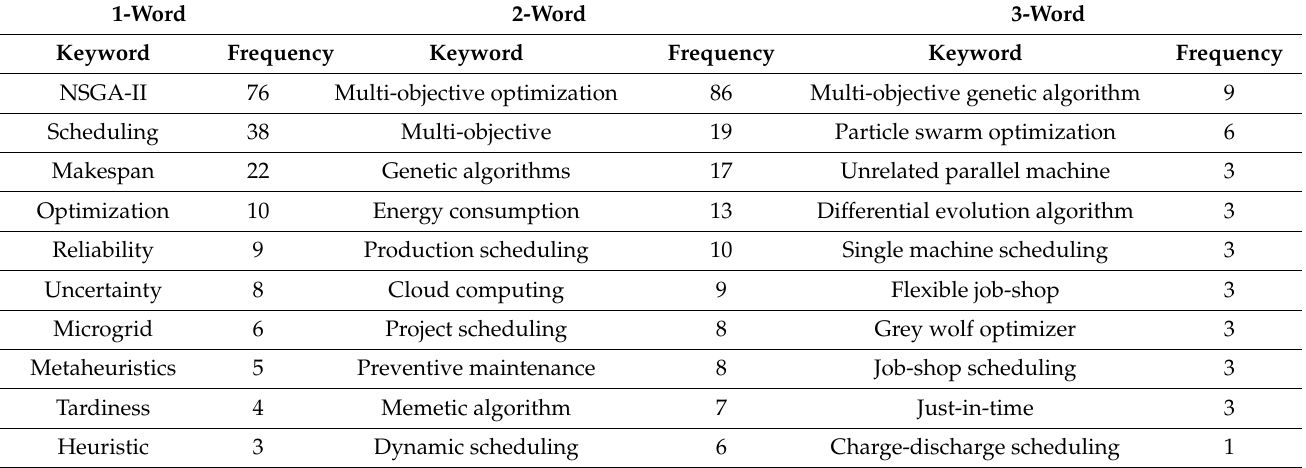
Table 11. The top 10 keywords of 1-word, 2-word, and 3-word lengths (Scopus